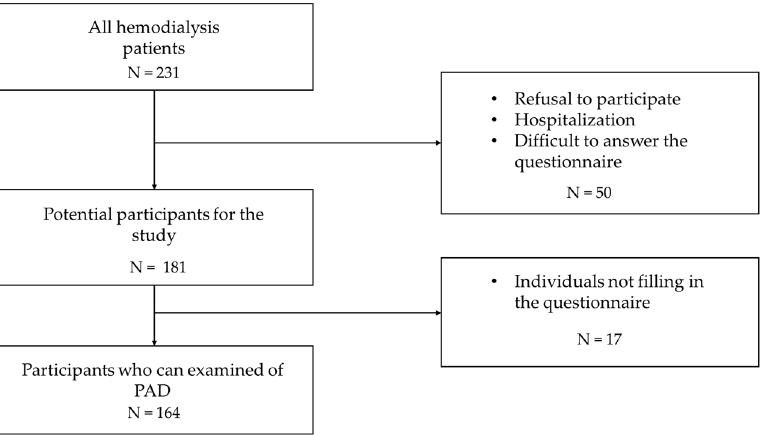
Figure 1. Flowchart of participant selection for the analysis. Of the 231 hemodialysis patients, 67 were excluded from the study and 164 participated. PAD, peripheral arterial disease.